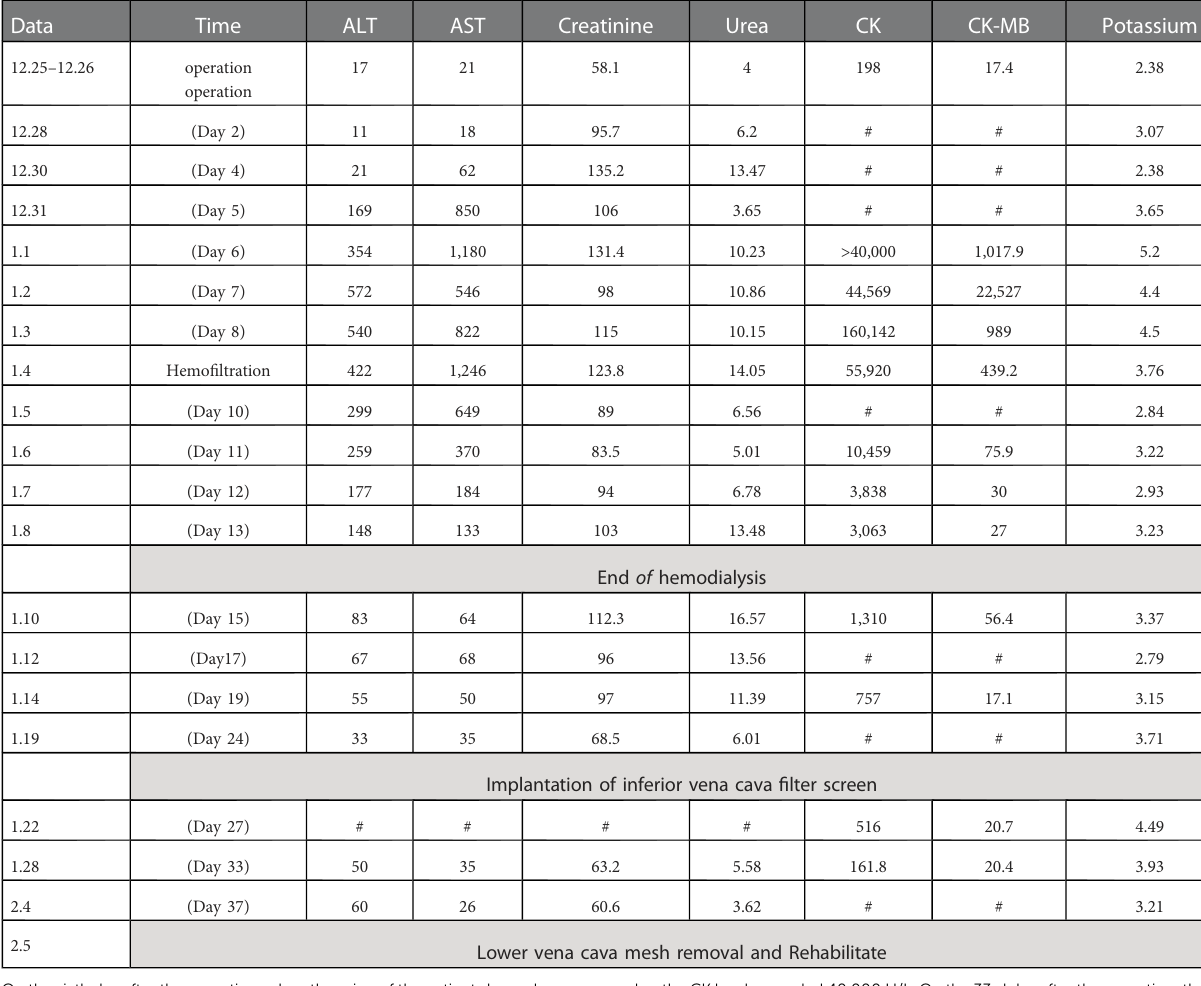
TABLE 1 Monitoring of various indices of patients during hospitalization: ALT (9 – 50 U/L) AST (15 – 40 U/L) creatinine (57 – 97 µmol/L) urea (3.1 – 8 mmol/L) CK (50 – 310 U/L) CK-MB (2 – 25 U/L) Potassium (3.5 – 5.5 mmol/L).